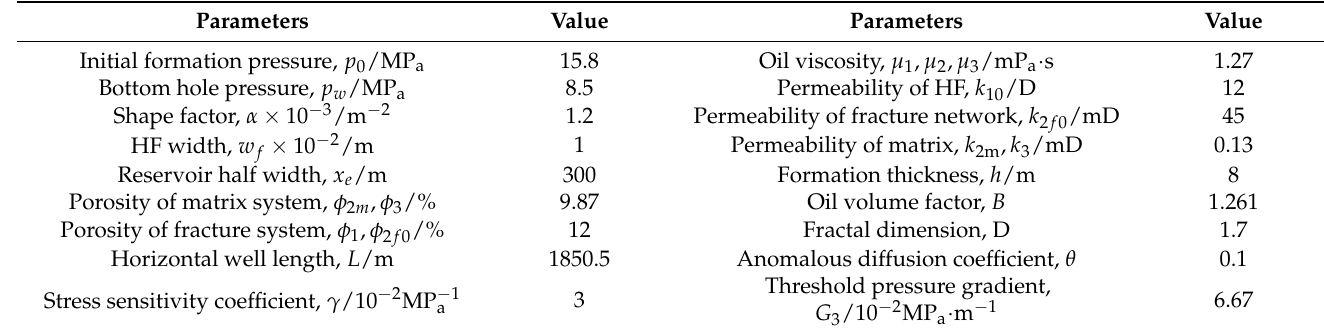
Table 2. Basic parameters of an oil well in the X Oilfield.